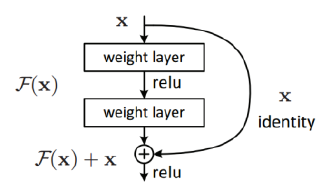
Figure 2. Residual block (He et al.,